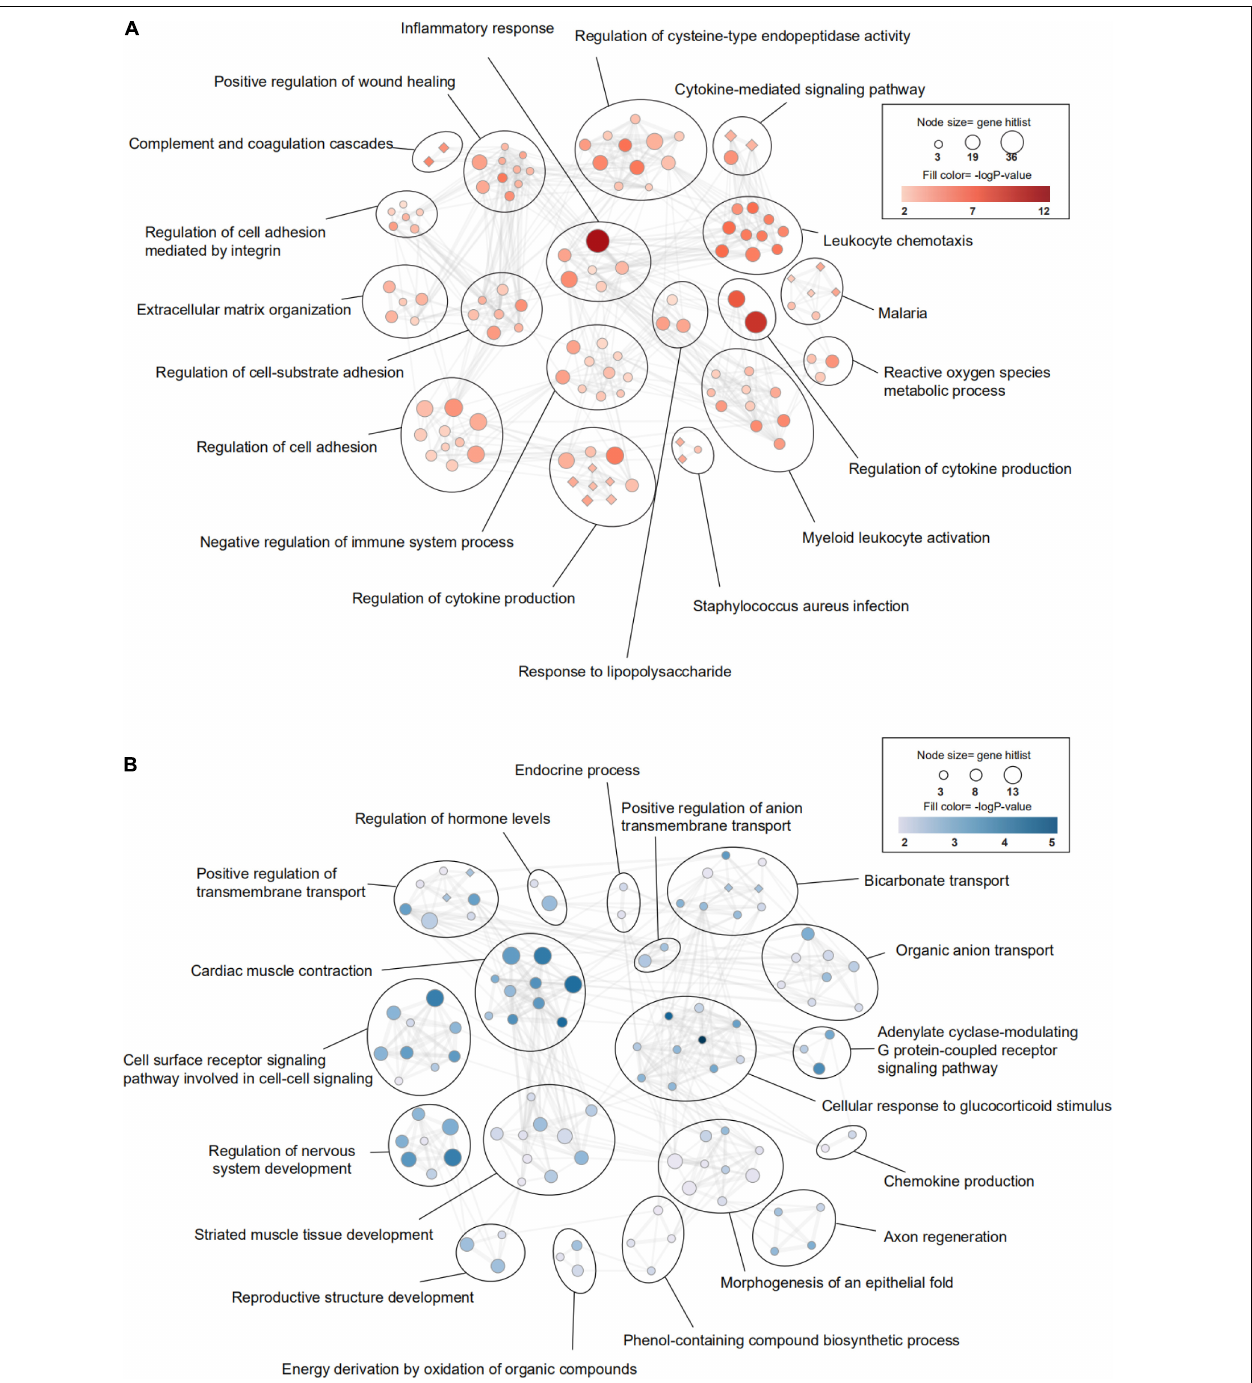
FIGURE 4 | Transcriptomic differences in the brain between young and aged mice. (A) Gene Ontology (GO) and KEGG (Kyoto Encyclopedia of Genes and Genomes) enrichment analysis of significantly upregulated differentially expressed genes (DEGs) and (B) downregulated DEGs between young mice and aged mice after sham surgery was performed using Metascape. The significantly enriched GO terms and pathways ( P < 0.01, z-score > 2) are presented in enrichment maps, and all of them are grouped into clusters based on membership similarities. The color of the nodes in the maps indicates the P value, and the size of the nodes reflects the number of genes in the hit list. Terms with a similarity > 0.3 are connected by lines. Circular nodes reflect GO terms, and diamond-shaped nodes reflect KEGG pathways. n = 3 per